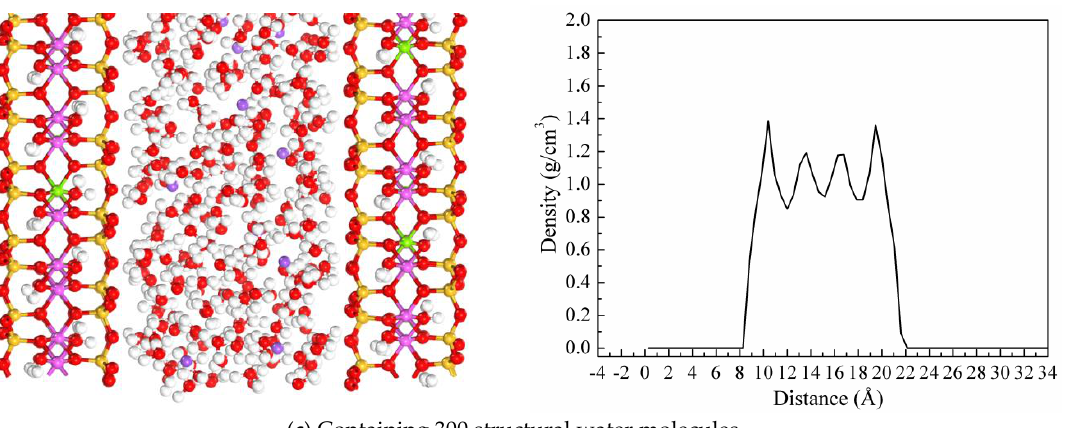
Figure 12. Structures and density distributions of water in montmorillonite layers containing ( a ) 100, ( b ) 200, and ( c ) 300 structural water molecules, respectively.